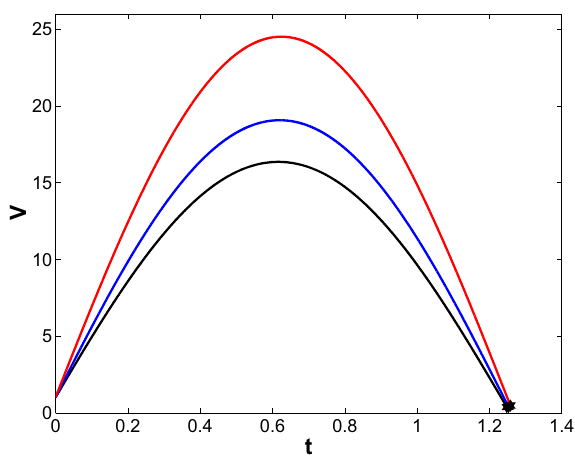
Fig. 5 The evolution of the volume factor V ( t ) for N = 2, f 0 = − 1 . Initial values of H a ( 0 ) , H b ( 0 ) are chosen as in Fig. 6 (see the 12 correspondingcolorsofsolidcurves)andstartingvaluesofscalefactors are a ( 0 ) = 1, b ( 0 ) = 1, c ( 0 ) = 1. The black star denotes the moment